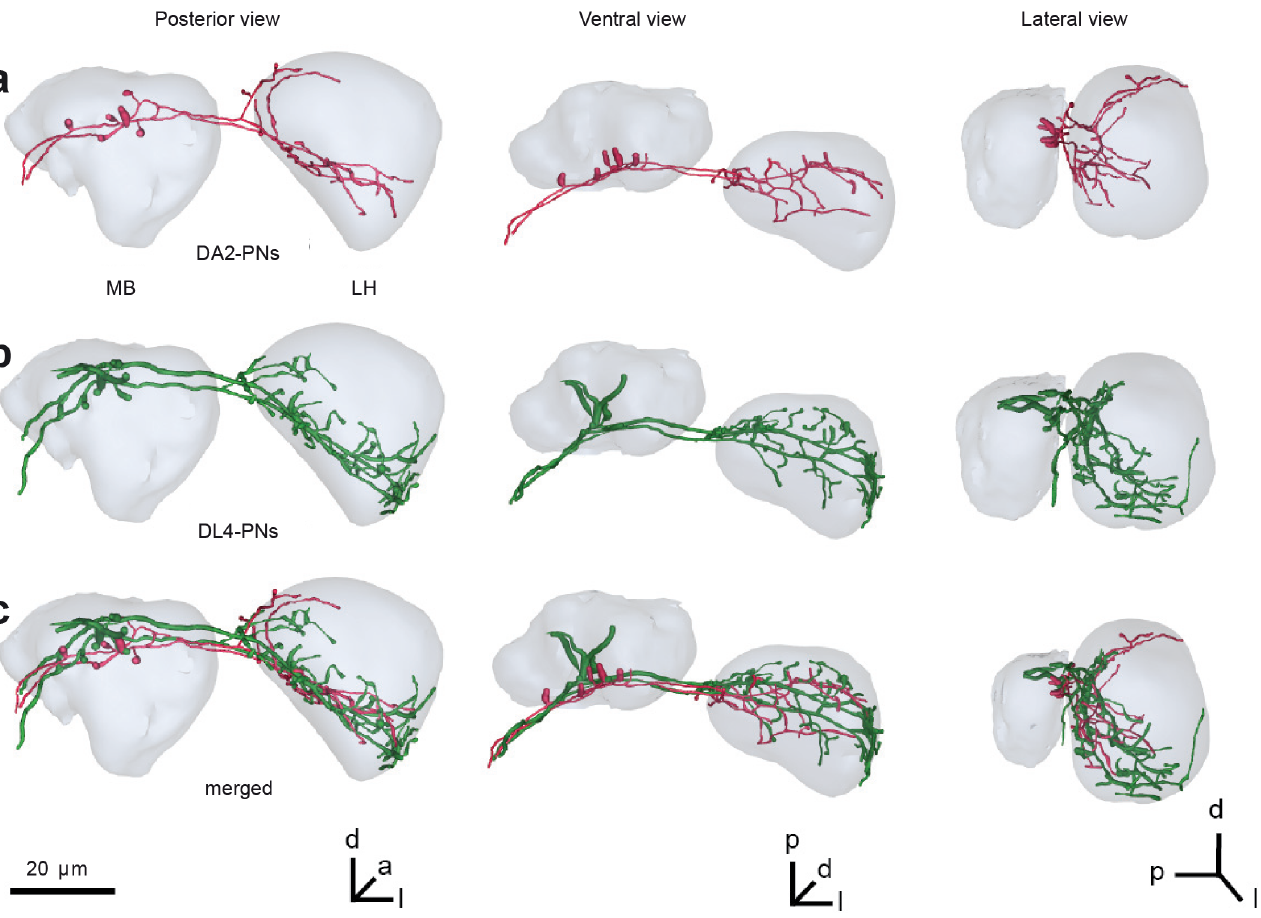
Fig 3. Innervation patterns of DL4 and DA2 PNs in MB and LH. ( A ) Reconstruction of two DA2 PNs. ( B ) Reconstruction of two DL4 PNs. ( C ) comparison of DA2 and DL4 domains after registration of datasets into a common reference space. DA2 and DL4 PNs overlap in the base of the MB and